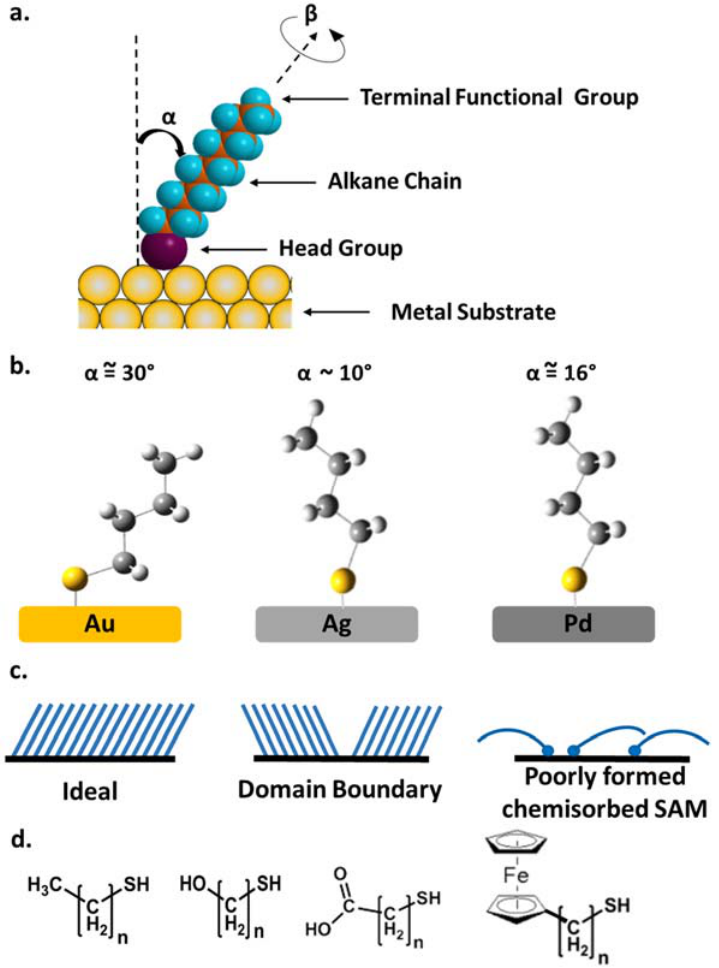
( c ) Schematic illustration of SAMs forming dynamics; ( d ) Different terminal functional